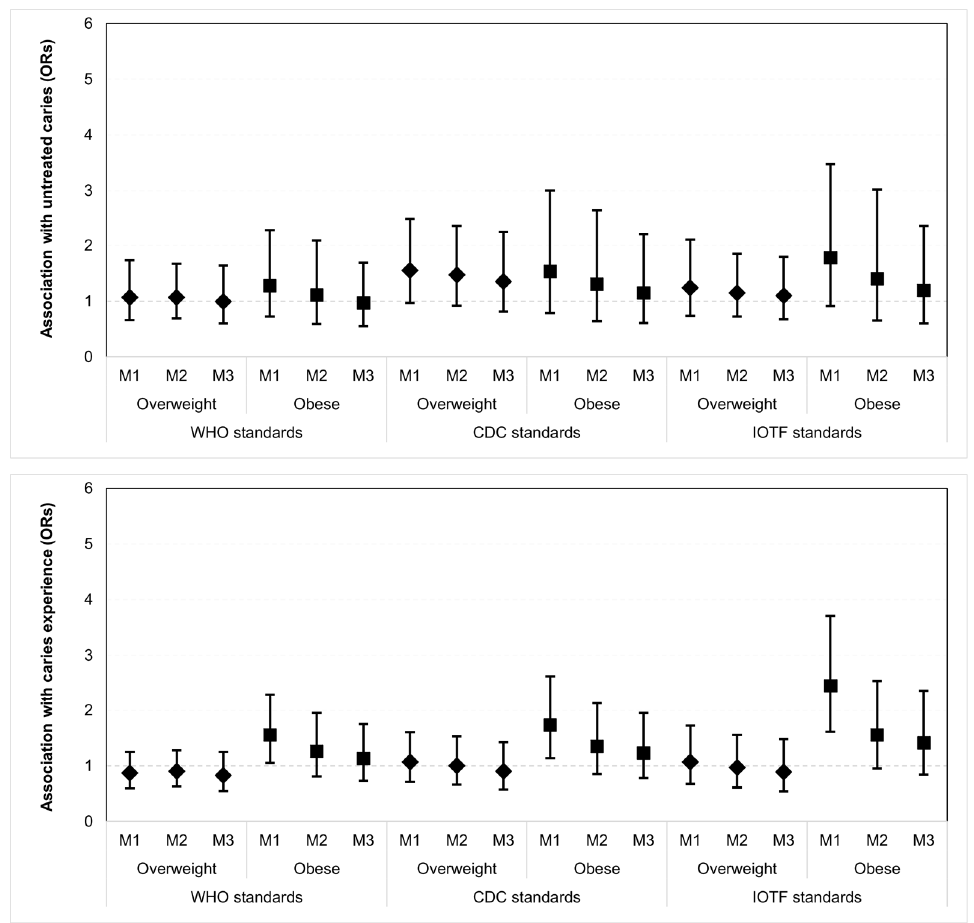
Figure 2. Crude and adjusted estimates (odds ratios, ORs) for the association of overweight and obesity (as defined by three international standards) with the prevalence of untreated caries and caries experience among 2–5-year-old children ( n = 2275). M1, M2 and M3 correspond to Models 1, 2 and 3 in Table 4.